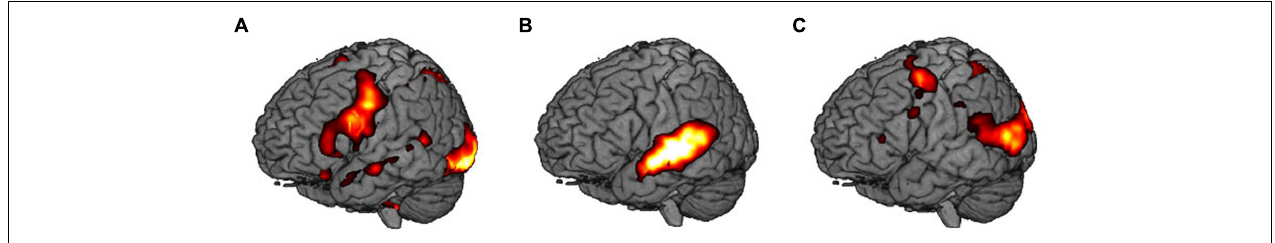
FIGURE 3 | Main contrasts in brain activity: (A) visual encoding, V vs. S, (B) audiovisual encoding, AV vs. V, and (C) sensorimotor encoding, SMO vs. AV.